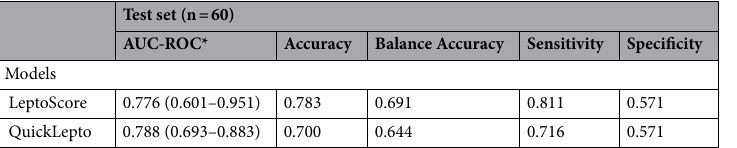
Table 2. Performance metrics of LeptoScore and QuickLepto in validation cohorts. *[95% Confidence Interval] based on 2000 bootstrap resamples.